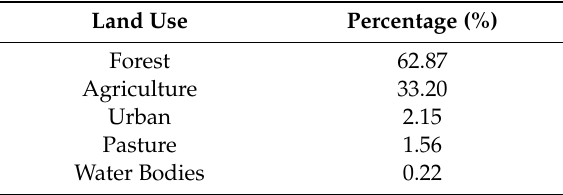
Table 1. Land-use summary of the Melen Watershed.